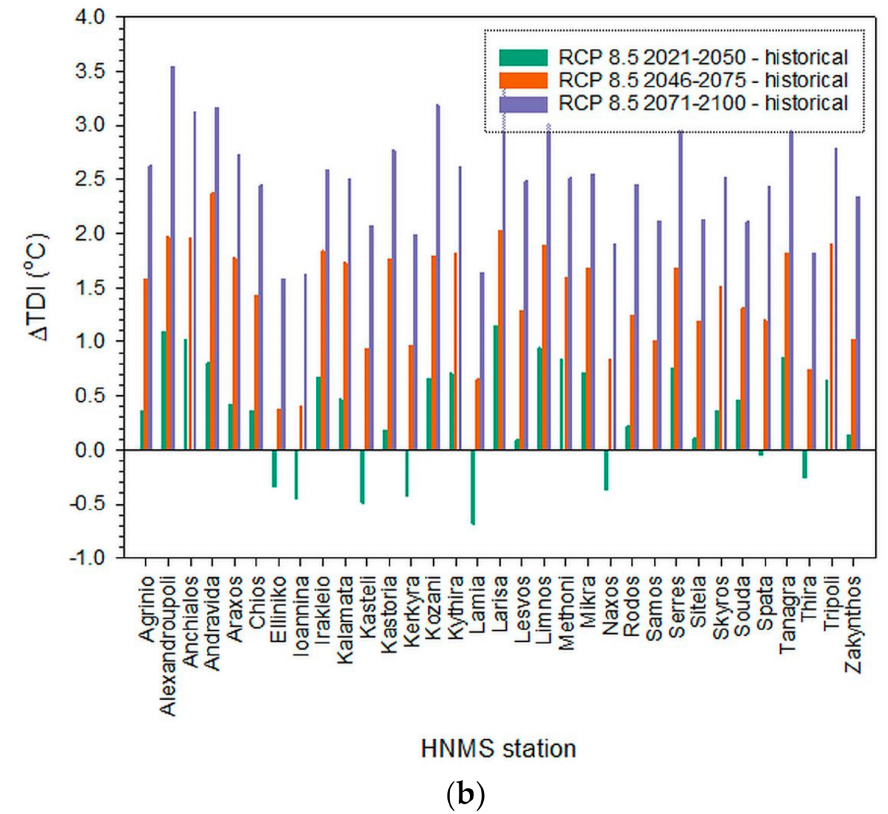
Figure 3. Annual mean ∆ TDIs for all HNMS sites (in alphabetical order) as derived from the TMYs-MC during the historical period of 1985–2014 and the future epochs of 2021–2050, 2046–2075, 2071–2100 under the ( a ) RCP 4.5 and ( b ) RCP 8.5 IPCC scenarios. The definition of ∆ TDI is given in the text. Table 4. Average annual TDI (in ◦ C) and average annual ∆ TDI (in ◦ C) values for all sites and periods considered; the standard deviation from the mean is shown in parenthesis. The definition of ∆ TDI is given in the text.